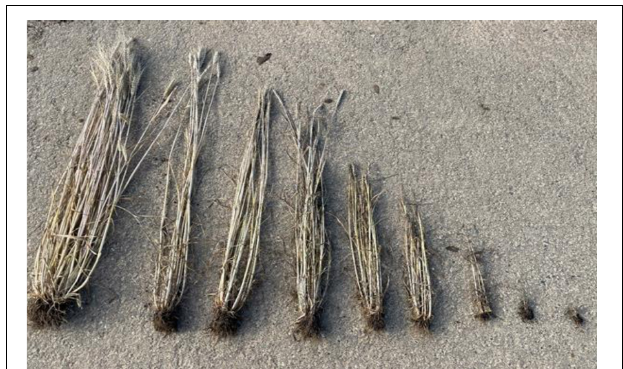
FIGURE 1 | Symptom scoring, from left to right 1–9; 1-asymptomatic, 2-very weak growth reduction, normal tillering; 3-weak growth reduction, normal tillering, marked yellowing of the leaf tips (not shown); 4-weak growth reduction, reduced number of ears; 5-significant reduction in growth, reduced number of tillers and spike-bearing stalks; 6- weak growth reduction, greatly reduced number of shoots and ears; 7-plant with one to four shoots, no ears or ears stuck in the bract, strongly dwarfed; 8-plant without shoots, no spikes, heavily dwarfed; 9-plant